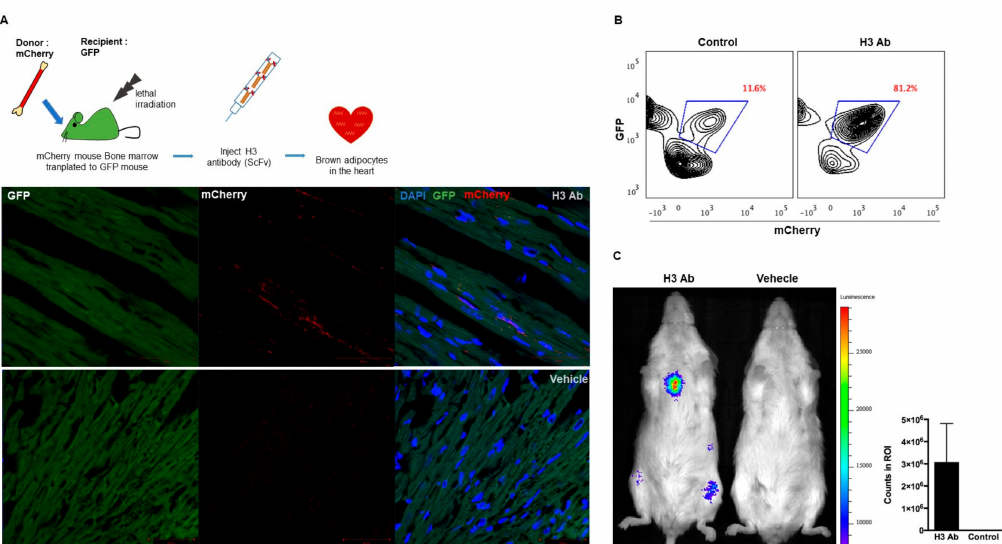
Figure 2. H3 antibody induces cell migration: ( A ) Research design used to investigate the migration of di ff erentiated HSCs from mouse bone marrow to heart. Bone marrow from mCherry + mice was adoptively transplanted into lethally irradiated GFP + mice, which were then injected with H3 Ab (50 µ g / mouse, i.p., two times / week) for 3 weeks. Following the treatment, hearts were harvested from perfused mice and analyzed by immunofluorescence histochemistry. GFP + heart tissue sections (10 µ m) were incubated with anti-mCherry and DAPI antibodies and then scanned by confocal microscopy. Remarkably, more mCherry + cells were found in the hearts of mice treated with H3 Ab versus vehicle. Scale bars = 50 µ m. ( B ) Harvested hearts were analyzed by flow cytometry. Analysis showed that more donor mCherry + cells migrated to the heart in the GFP + mice injected with H3 Ab versus vehicle alone. ( C ) Representative images (1 week posttransplantation) of FVB / NJ mice transplanted with luc + bone marrow cells that were infected in vitro with the H3 Ab lentiviral vector or no Ab (control). Regions of Interest (ROIs) were used to quantify counts (mean ± s.d.; n =